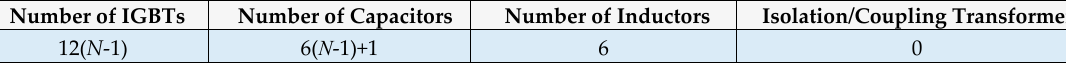
3.8. Simplified RPC Based on a Half-Bridge Indirect Modular Multilevel Converter (HB-MMC2